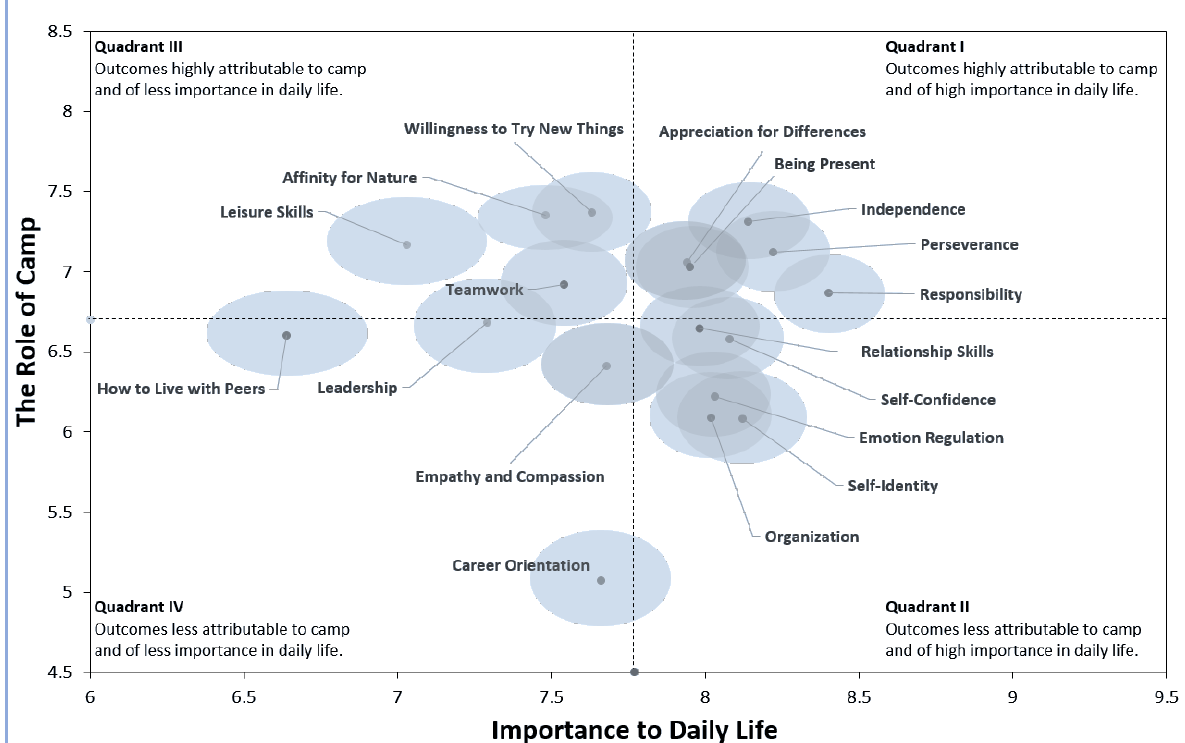
Figure 2. The Role of Camp in Developing Transferable Learning